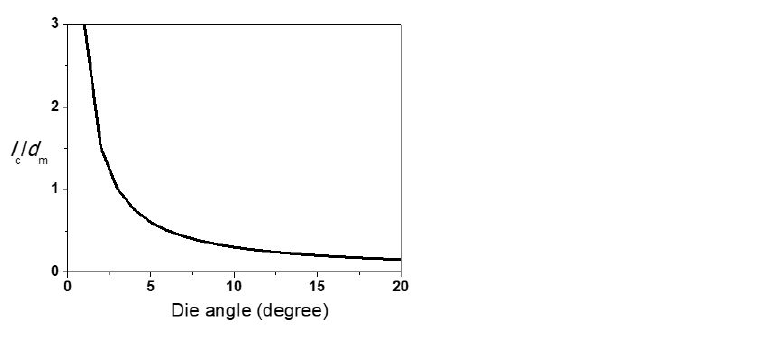
Figure 13. Calculated contact length of wire and die with die angle in the conventional die used in this